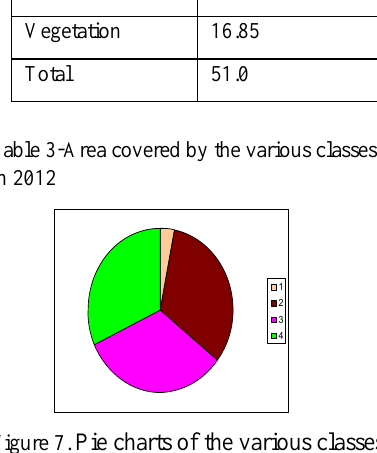
Figure 5. Pie charts of the various classes in 1986: 1-bare surface, 2-built-up, 3-farmland, 4- vegetation